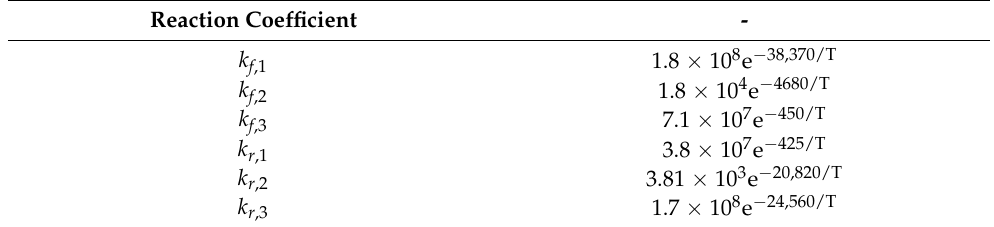
Table 2. Value of reaction